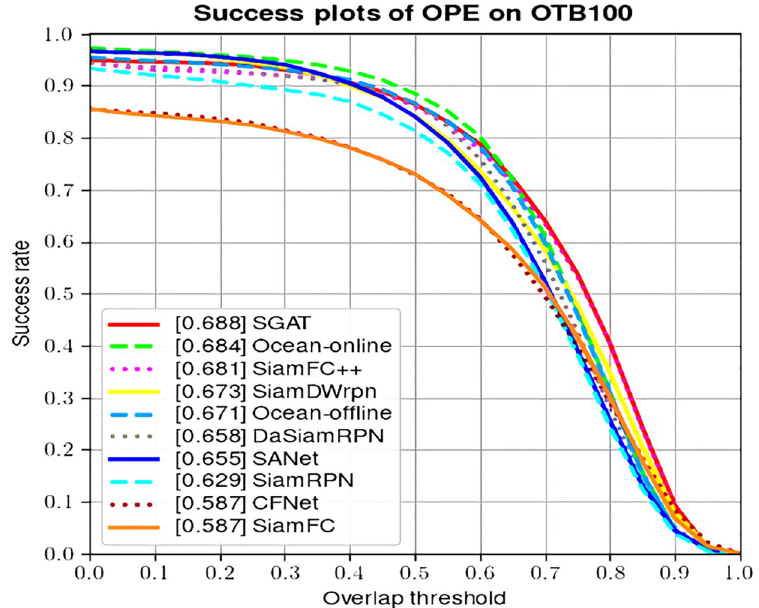
Fig 3. Comparison with state-of-the-art trackers on OTB-100 in terms of success plots.